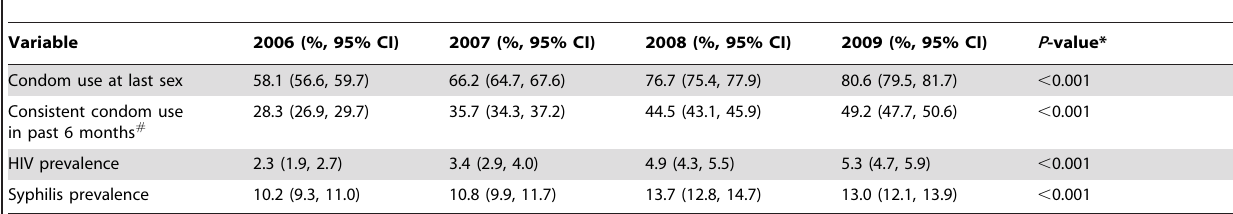
Table 4. Trends of condom use and disease rates among MSM surveyed in 16 Chinese cities from 2006 to 2009.